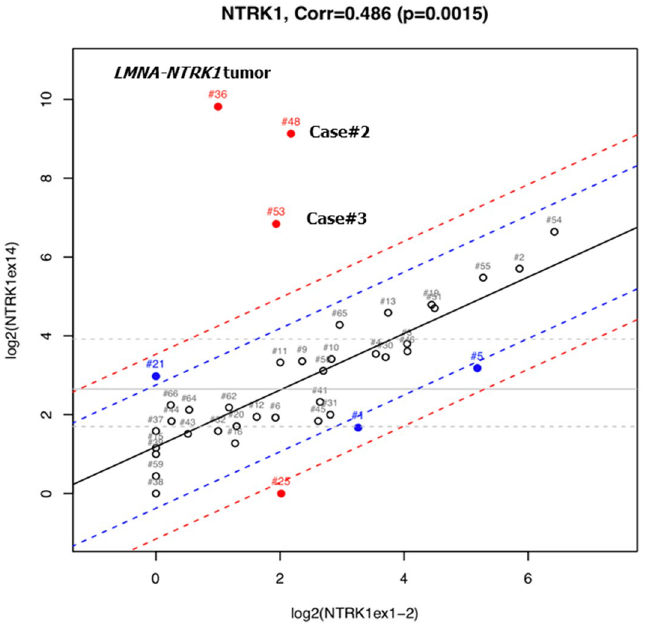
Figure 2. Nanostring analysis showing an imbalance of NTRK1 gene expression between probes targeted against the 5 ′ -side and 3 ′ -side sequences. Smirnov–Grubbs’ test was used to identify outlier. Blue and red lines represent 2SD and 3SD, respectively. #2 and # 3 correspond to Case #2 and #3, respectively, while #36 is a positive control tumor sample previously shown to have LMNA-NTRK1 fusion 22 . The samples other than Case #2 and #3 are not colorectal cancers. Data was analyzed with our accumulated dataset comprised of various types of malignancies. Case #21 seems to show statistically significant imbalanced expression (blotted between 2 and 3SD) of NTRK1 . This case is an inflammatory myofibroblastic tumor previously shown to have an ETV6- NTRK3 fusion in our previous study 20 in which we proposed that imbalanced expression of more than 3SD would be reliable for the presence of a fusion